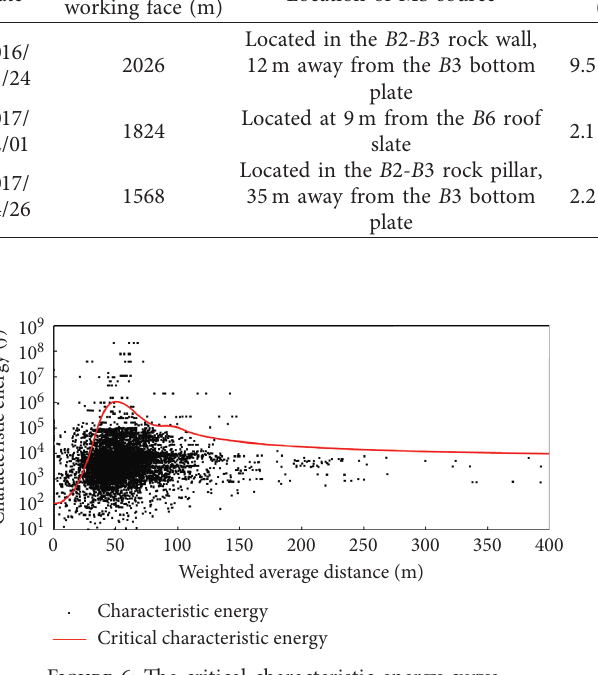
Figure 6: The critical characteristic energy